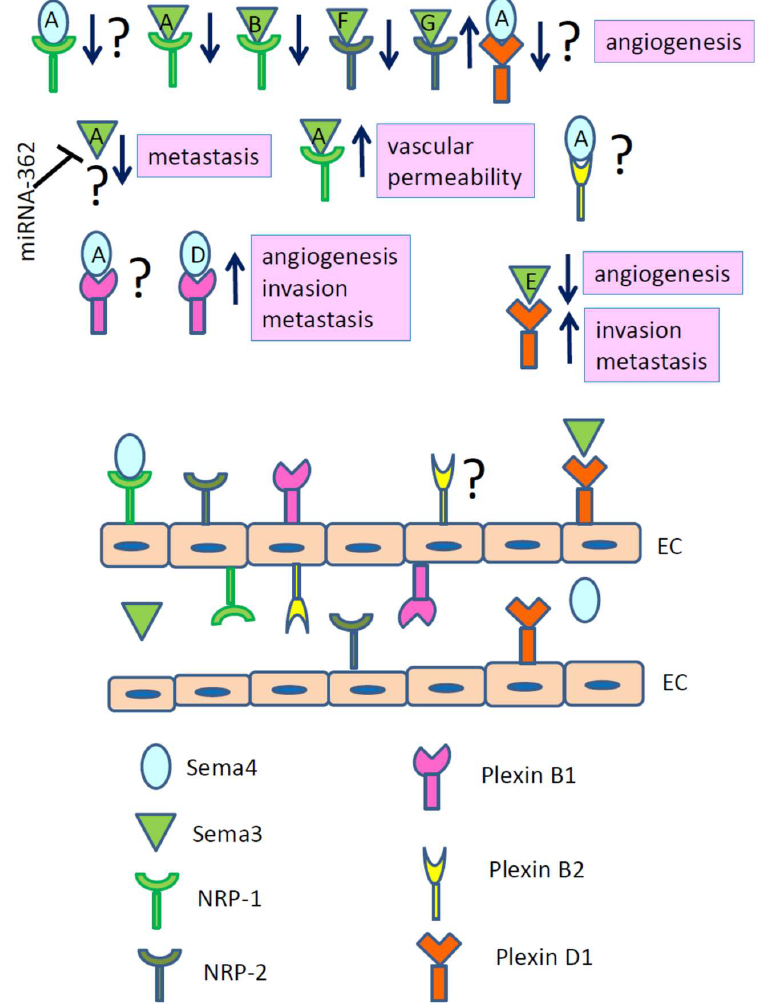
Figure 1. Semaphorins signaling by linking the corresponding receptors contribute to several hallmarks of cancer including, but not limited to, angiogenesis and metastasis. Sema4A binding NRP-1 receptor sends anti-angiogenic signal to endothelial cells (EC). The figure shows that Class III members of semaphorin family of proteins such as Sema3A, Sema3B, and Sema3F, inhibit angiogenesis